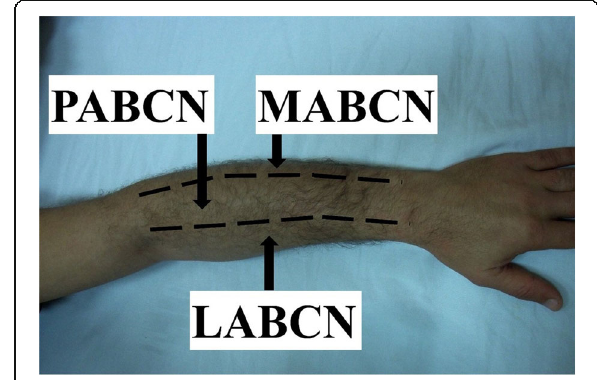
Fig. 5 Sensory territory of the posterior antebrachial cutaneous nerve (PABCN) in relation to the sensory territory of the medial antebrachial cutaneous nerve (MABCN) and the sensory territory of the lateral antebrachial cutaneous nerve